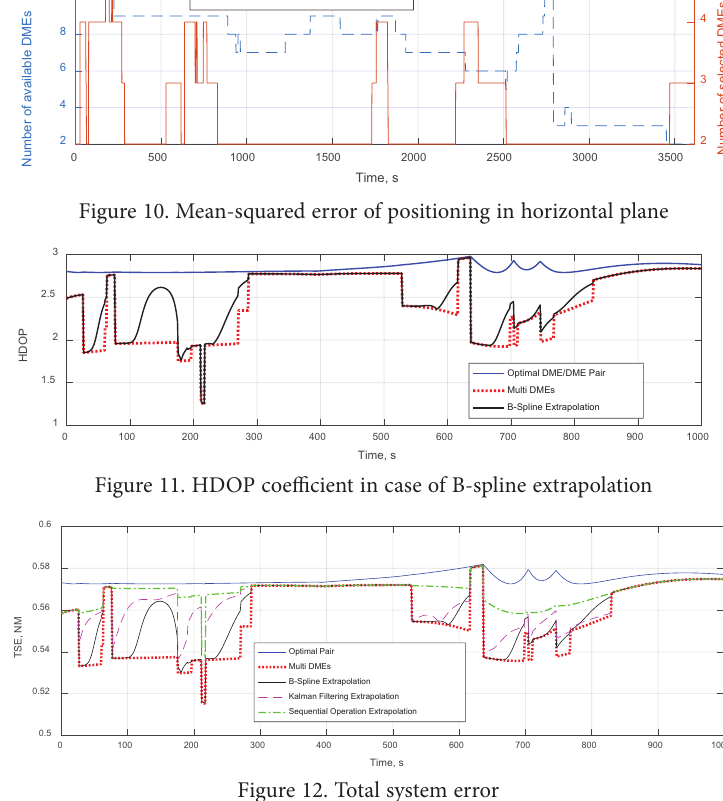
Figure 12. Total system